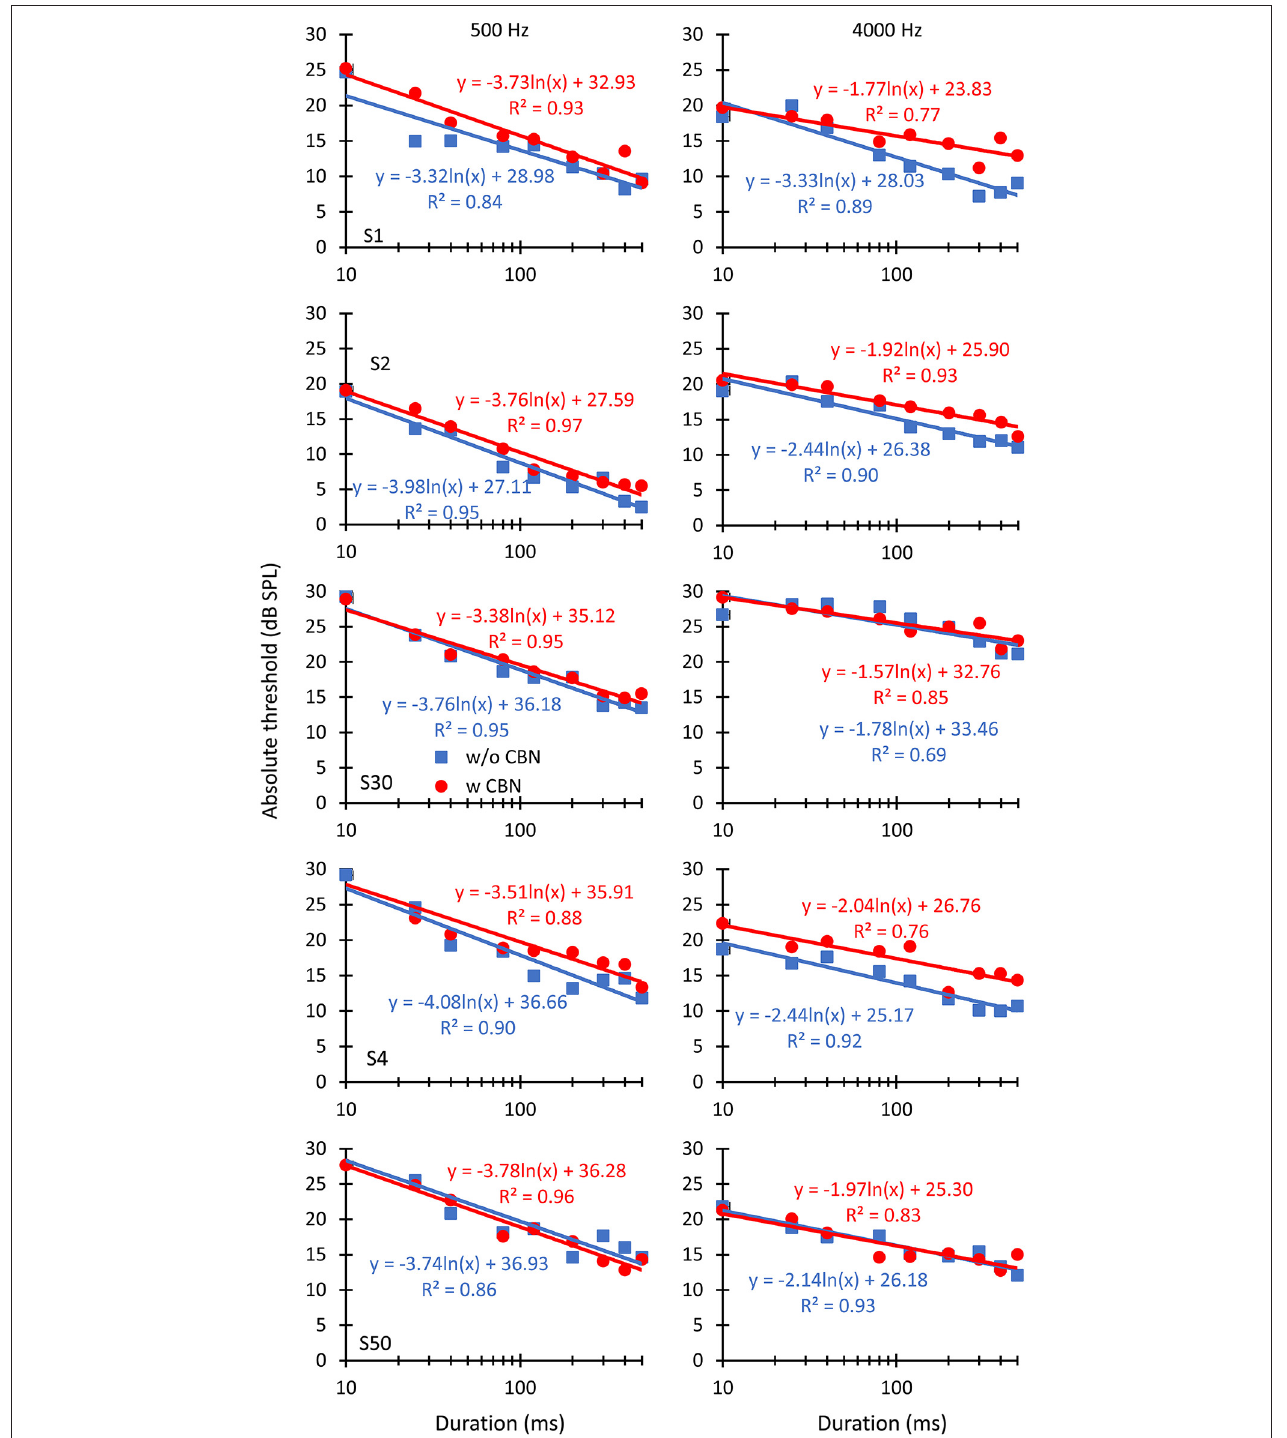
thresholds in the absence (“w/o CBN”, squares) and in the presence (“w CBN”, circles) of a CBN, as indicated by the inset in the left panel of the middle row. Lines illustrate least-squares fits to the data using the logarithmic functions given next to the data. R 2 is the proportion of variance in the data predicted by the